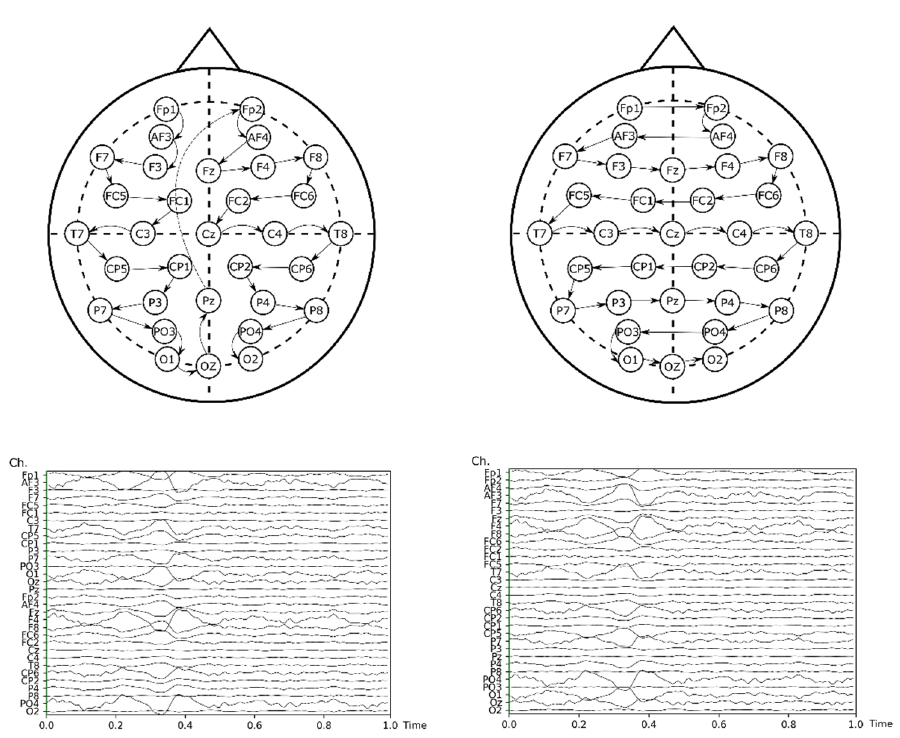
Figure 3. Re-arrangement of the EEG channels for the ANN analysis.